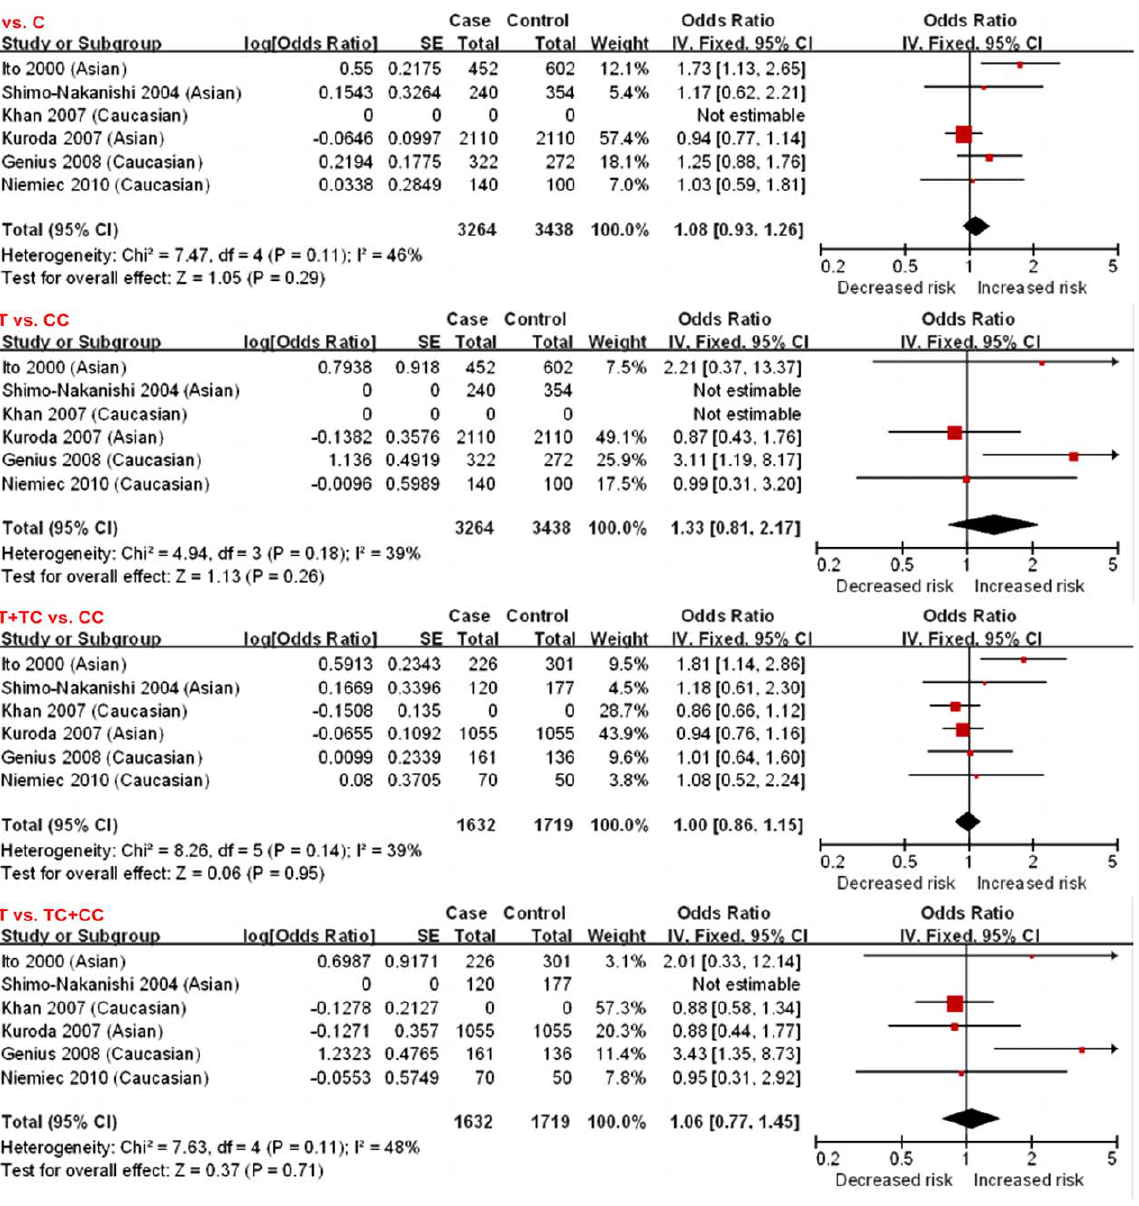
Figure 2. Forest plots for overall studies. Fixed effects models were used as no statistical heterogeneity across studies were observed (I 2 =46%, p=0.11; I 2 =39%, p=0.18; I 2 =39%, p=0.14; I 2 =48%, p=0.11, respectively). There was no statistical evidence of association (T vs. C: OR=1.08, 95%CI=0.93–1.26; TT vs. CC: OR=1.33, 95%CI=0.81–2.17; TT + TC vs. CC: OR=1.00, 95%CI=0.86–1.15; and TT vs. TC + CC: OR=1.06, 95%CI=0.77– 1.45). se: standard error; IV: inverse variance; CI: confidence interval.